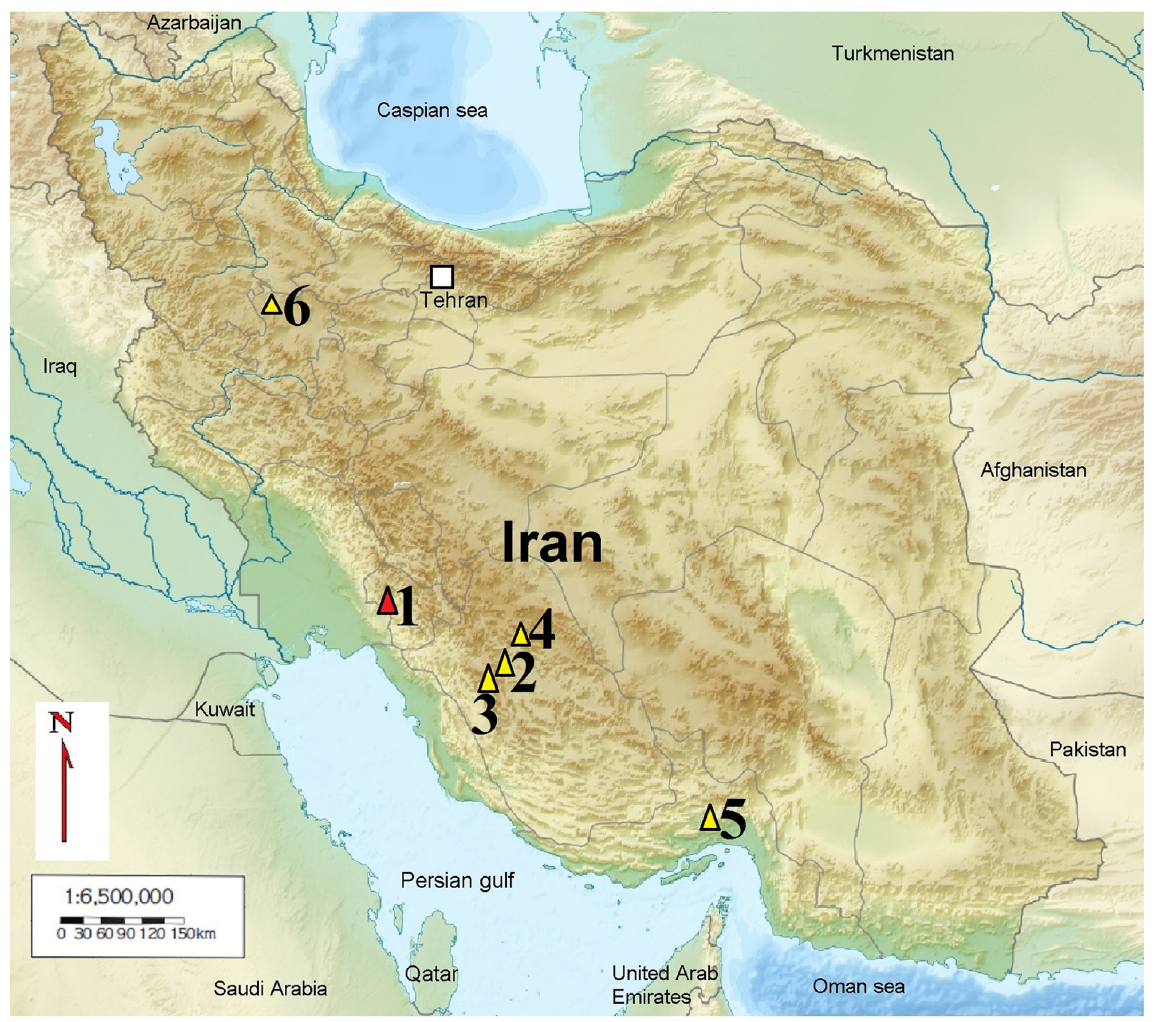
Fig. 2. Distribution of species of Chiraziulus Mauriès, 1983 in Iran (Mauriès 1987). C. troglopersicus sp. nov.: red dot (1); C. kaiseri : yellow dots (2–6). 1 . Neyneh Cave. 2 . “Chiraz” “montagne greseuse au nord de la ville”. 3 . 19 km W of Shiraz. 4 . 5 km N of Persepolis. 5 . Oasis 95 km N of Bandarabass. 6 . Sarab